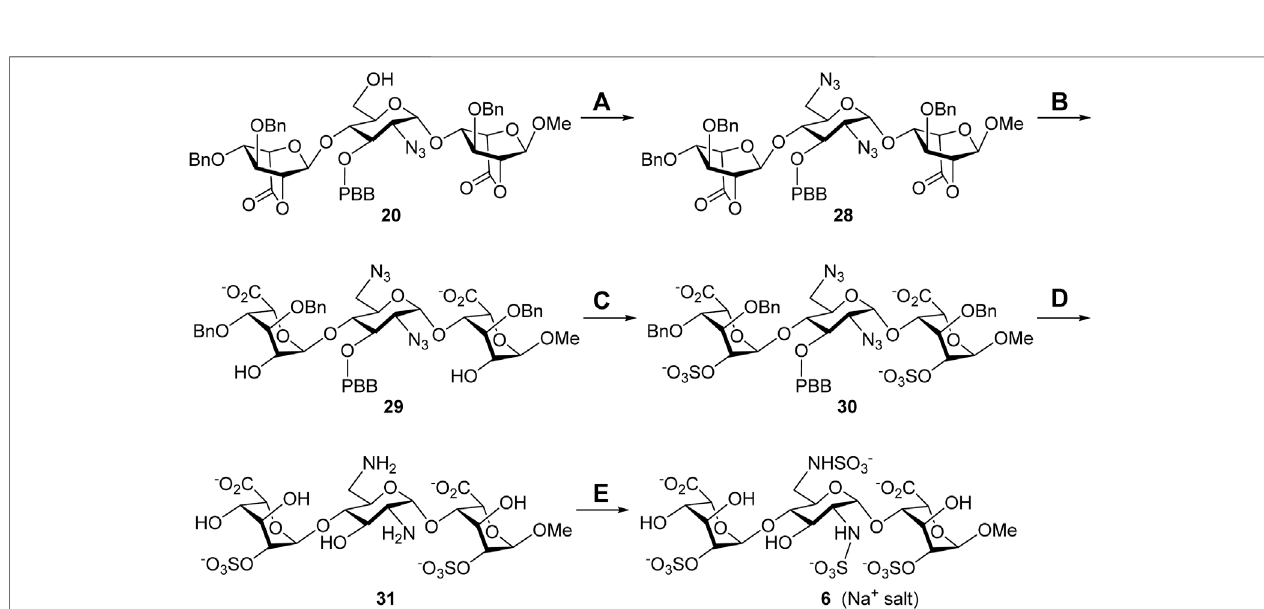
identi fi ed. Two sets of 2 J C-H coupling correlations between the anomeric carbon of the L-iduronic acid and H-5 were also recognized. All of the anomeric hydrogen atoms could be